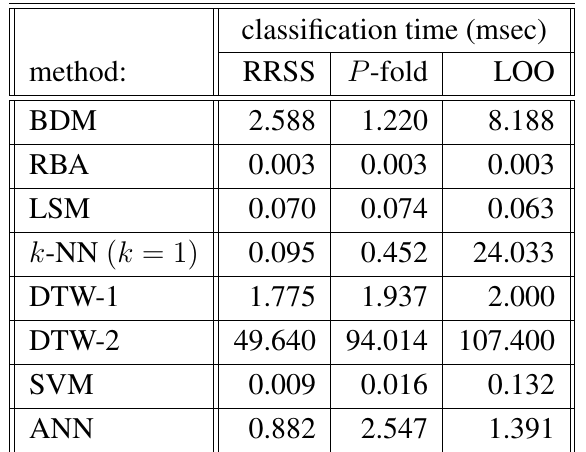
Table 14. The processing times required for classifying a single feature